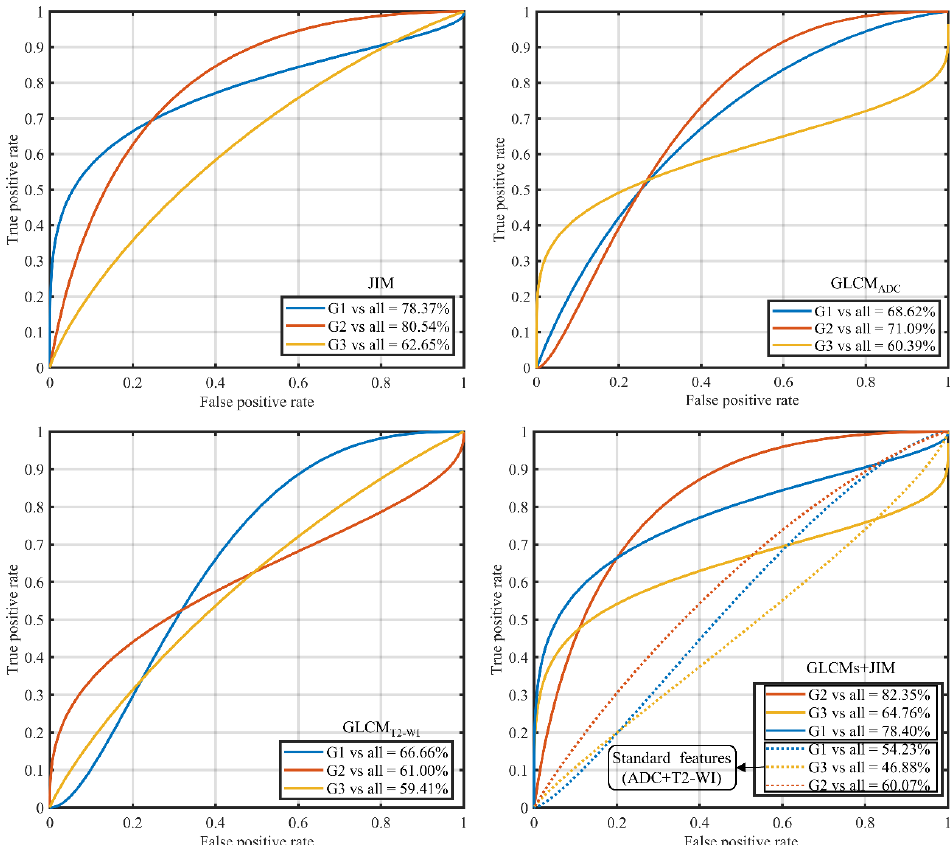
Figure 3. Multivariate analysis of texture features and RF classifier model. The AUC for predicting G1 (GS ≤ 6), G2 (GS = 3+4), and G3 (GS ≥ 4 + 3) using the JIM (19 features), GLCM ADC (19 features), GLCM T2-WI (19 features), all combined features (GLCMs + JIM, 19 × 3 features), and all of the standard features (histogram features derived from ADC and T2-WI images of PCa, 6 × 2 features). For training ( n = 40 samples) and testing ( n = 20 samples), balance samples were considered.